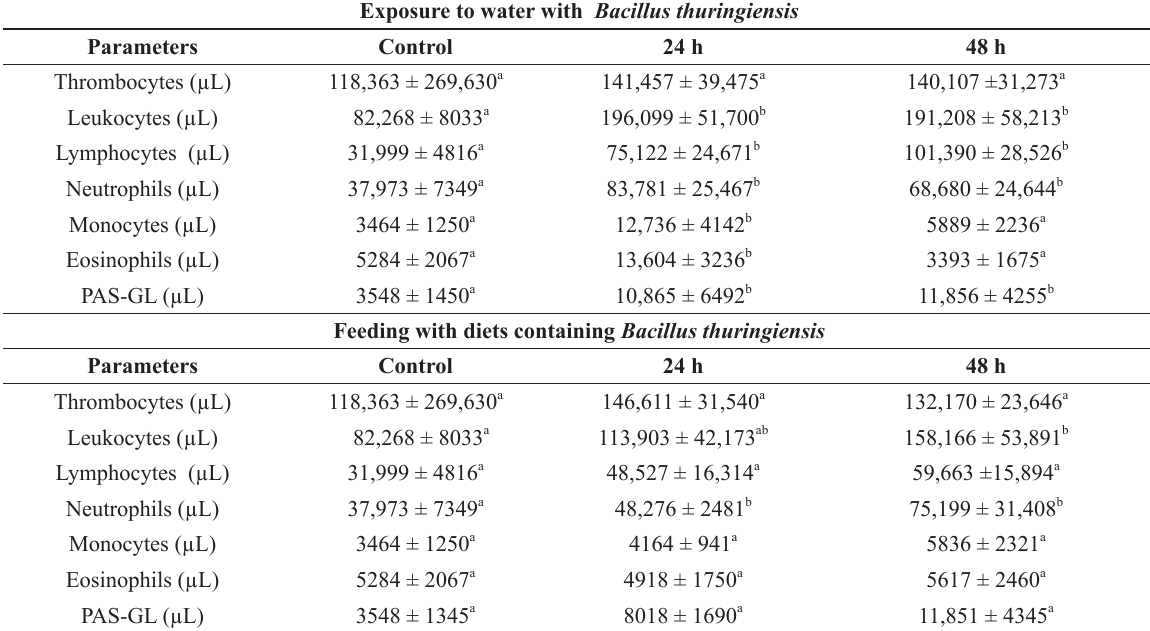
Thrombocytes and leukocytes of Piaractus mesopotamicus exposed to biopesticide based on Bacillus thuringiensis. Exposure to water with Bacillus